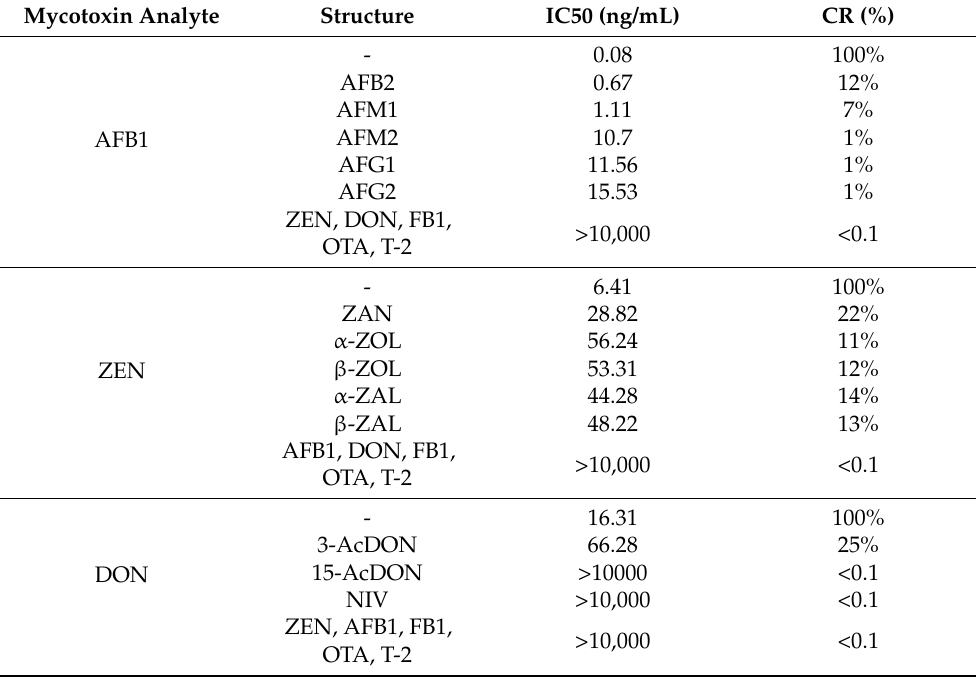
Table 1. IC50 and cross-reactivity (CR) of anti-AFB1/ZEN/DON MAb against related mycotoxins. ( n =